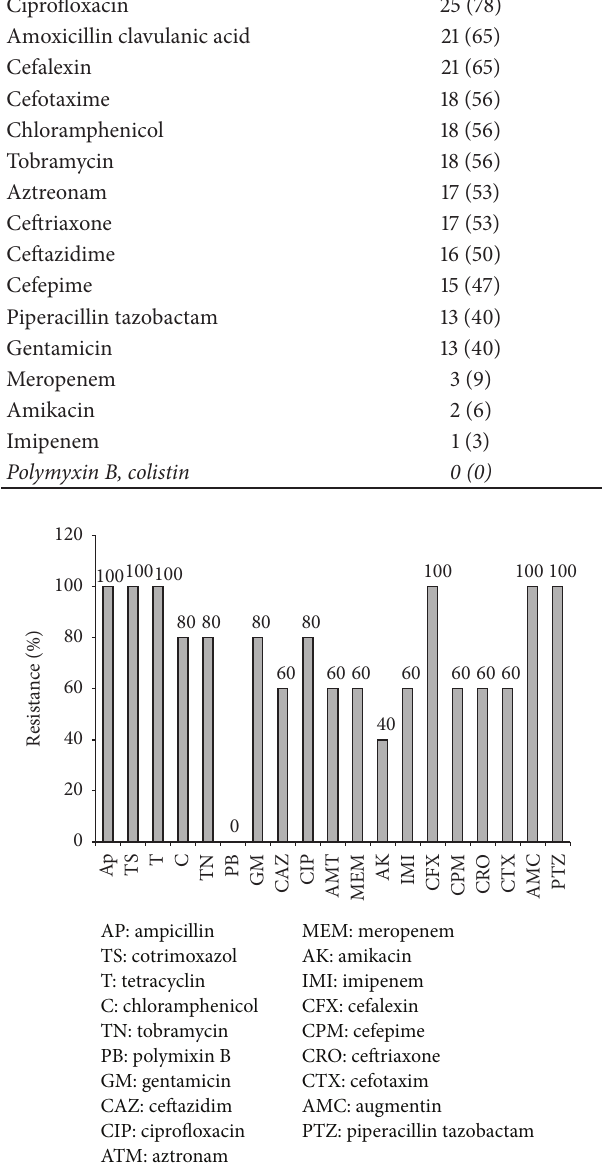
Figure 2: Antibiotic resistance patterns of nonfermenter Gram- negative strains isolated from diabetic foot